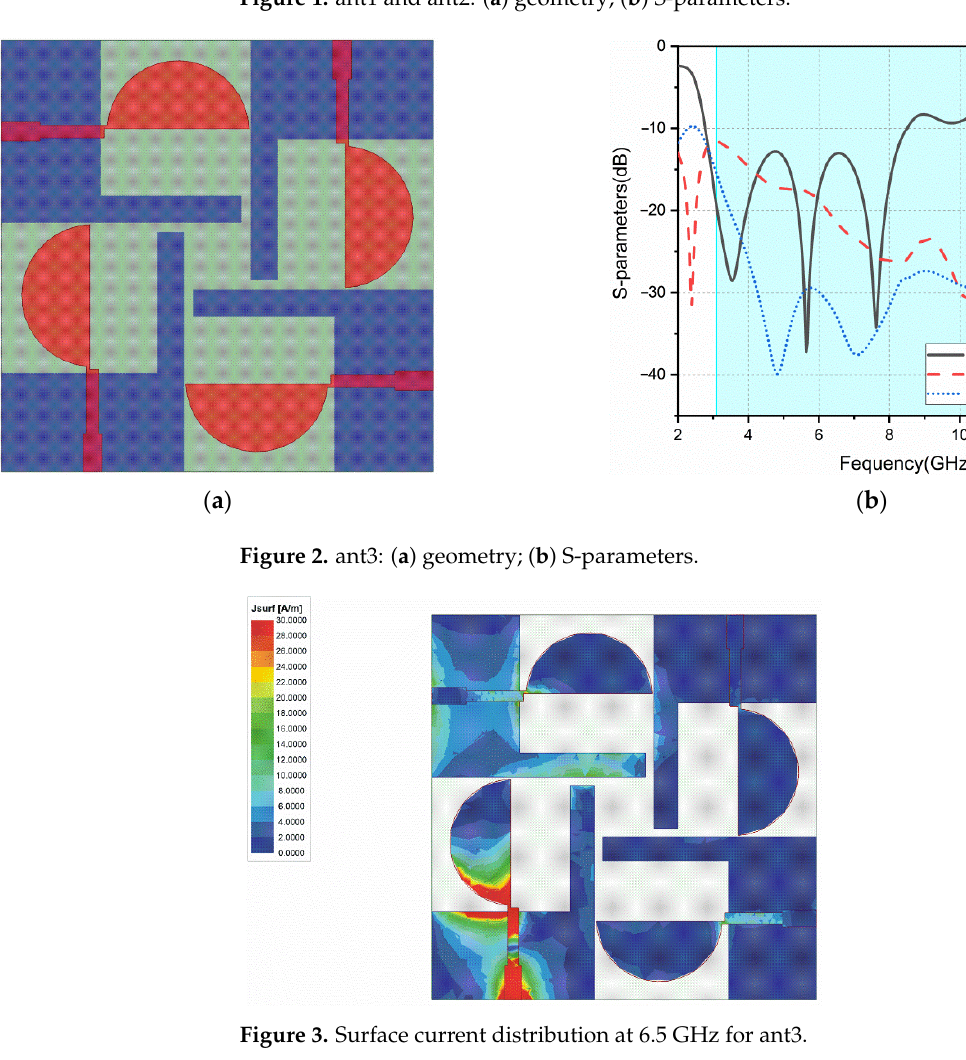
Figure 1. ant1 and ant2: ( a ) geometry; ( b ) S-parameters.